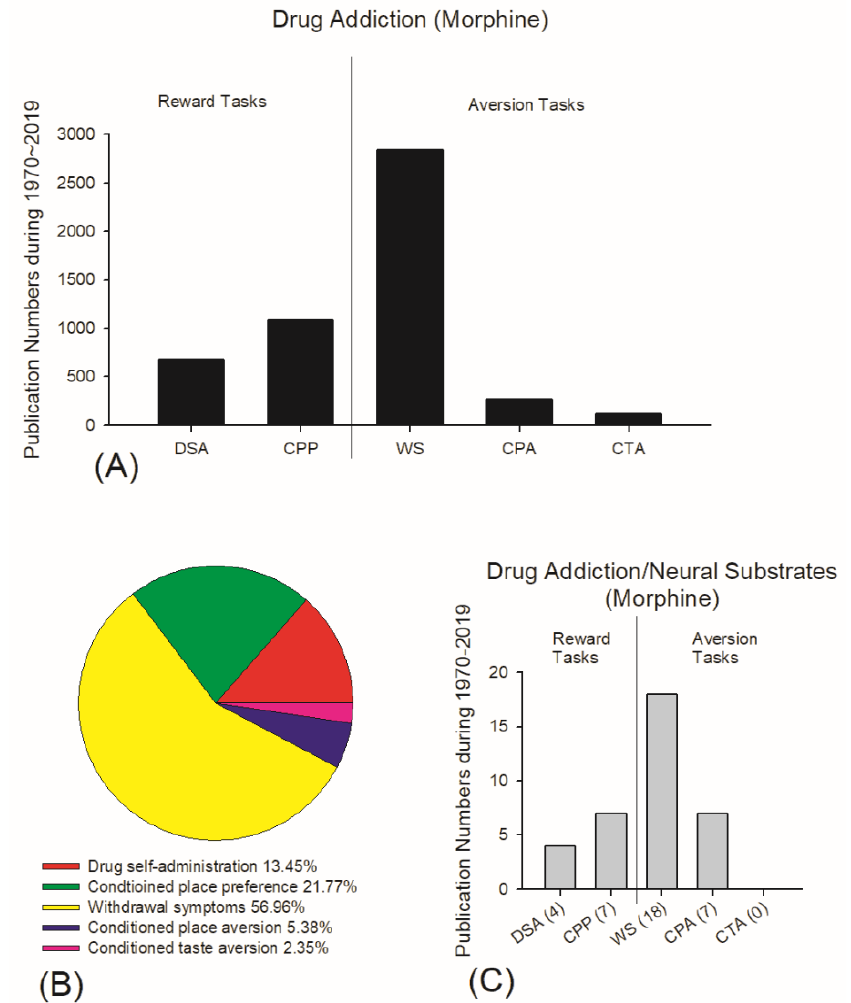
Figure 20. Publications related to morphine addiction in reward and aversive tasks during 1970–2019. ( A ) The number of publications on morphine addiction. Reward tasks include drug self-administration (DSA) and conditioned place preference (CPP). Aversive tasks involve withdrawal symptoms (WS), conditioned place aversion (CPA), and conditioned taste aversion (CTA). ( B ) The percentage of publications on morphine addiction for reward tasks in DSA and CPP and aversive tasks in WS, CPA, and CTA. ( C ) The number of publications on the involvement of neural substrates in morphine addiction for reward tasks in DSA and CPP and aversive tasks in WS, CPA, and CTA.